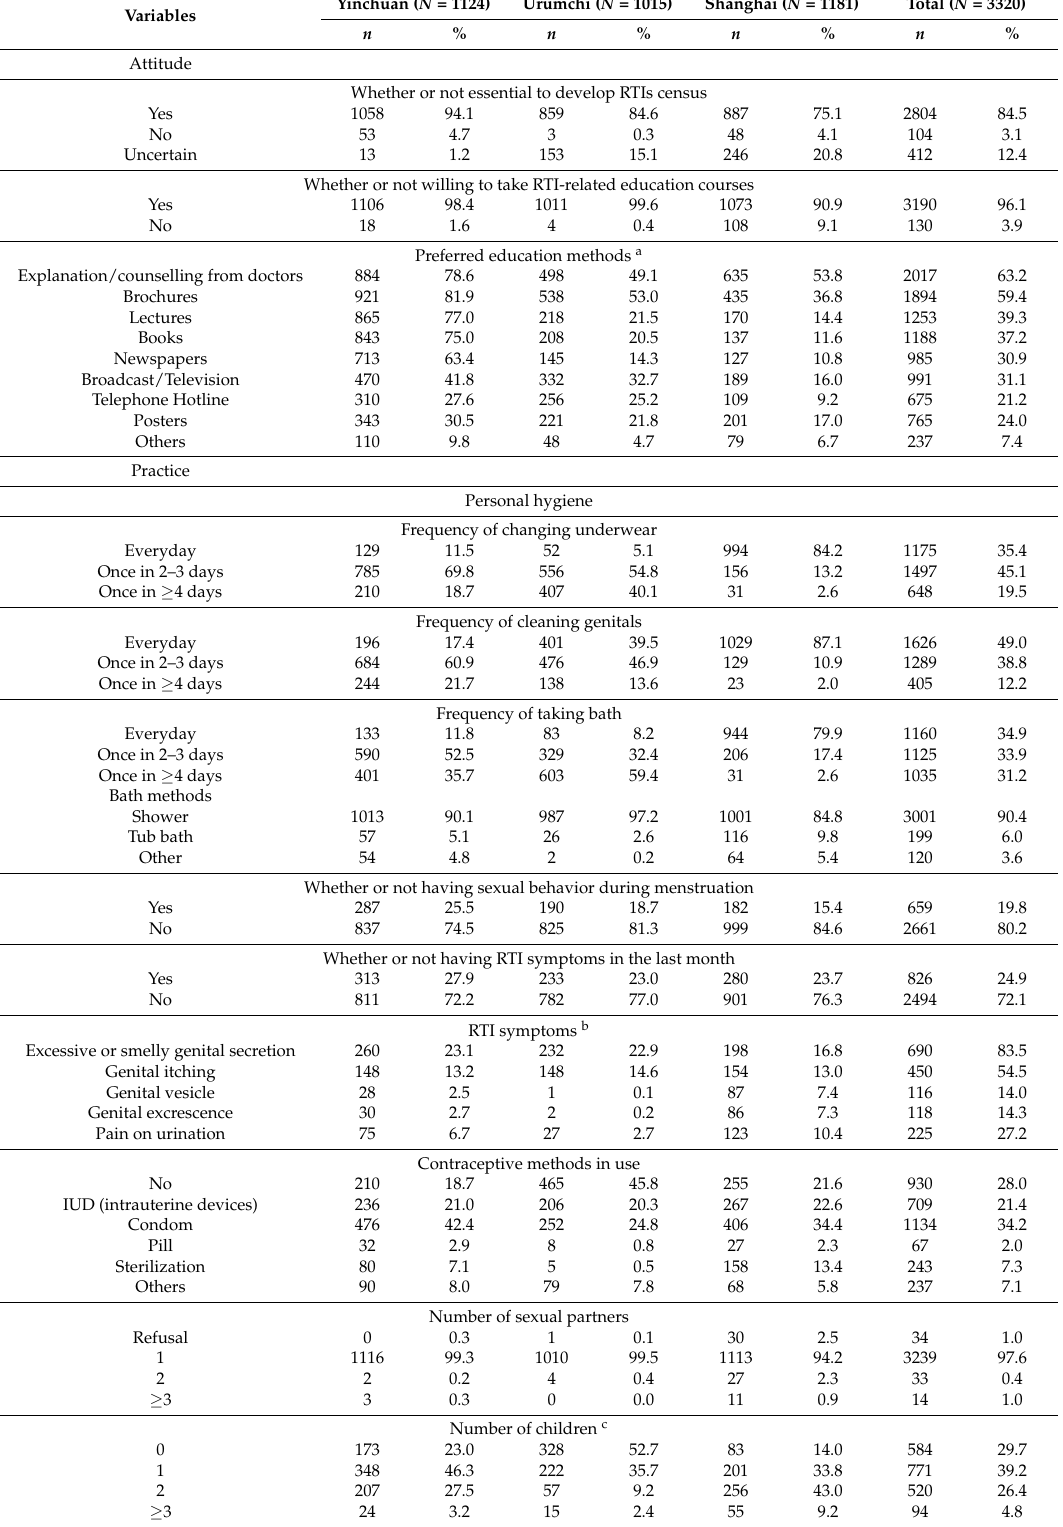
Table 2. RTI (reproductive tract infections)-related attitude and practices of the study participants. Variables Attitude